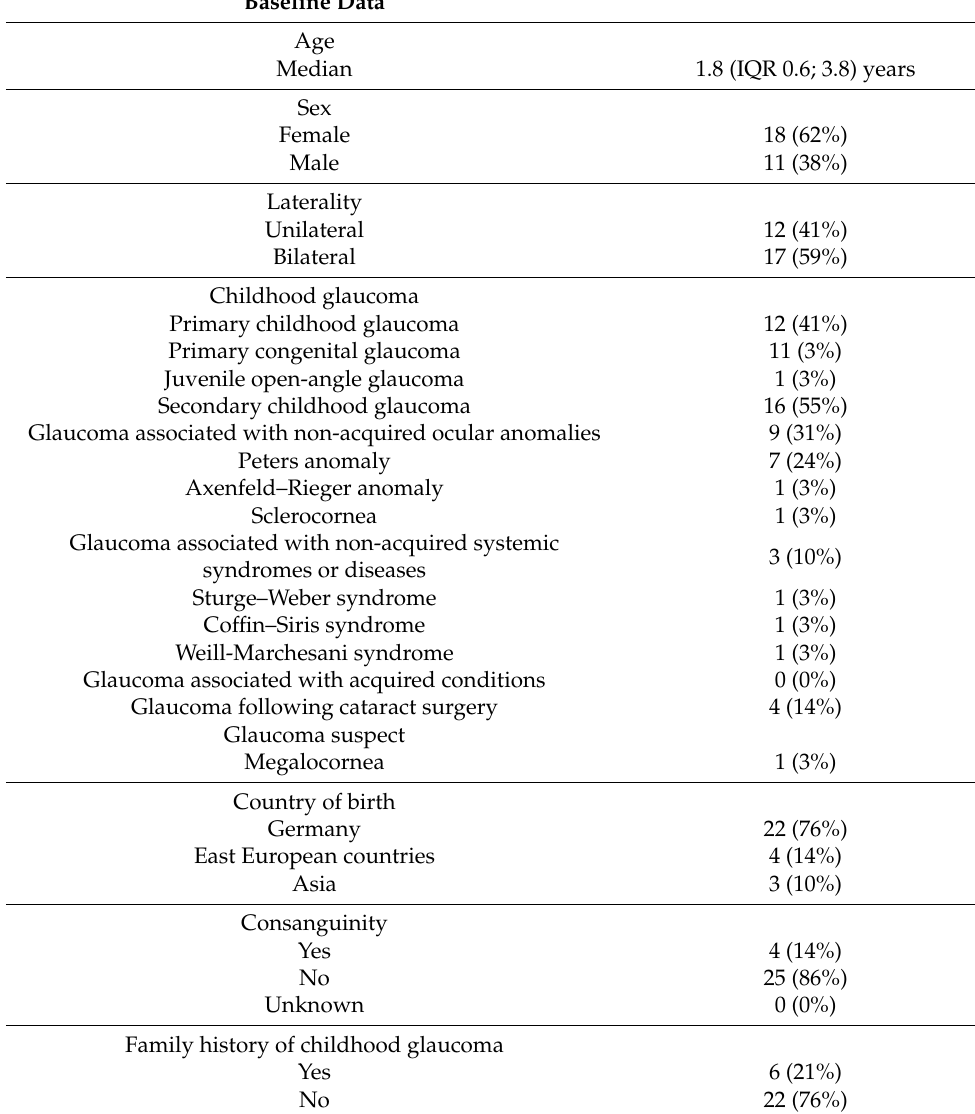
Table 3. Demographic